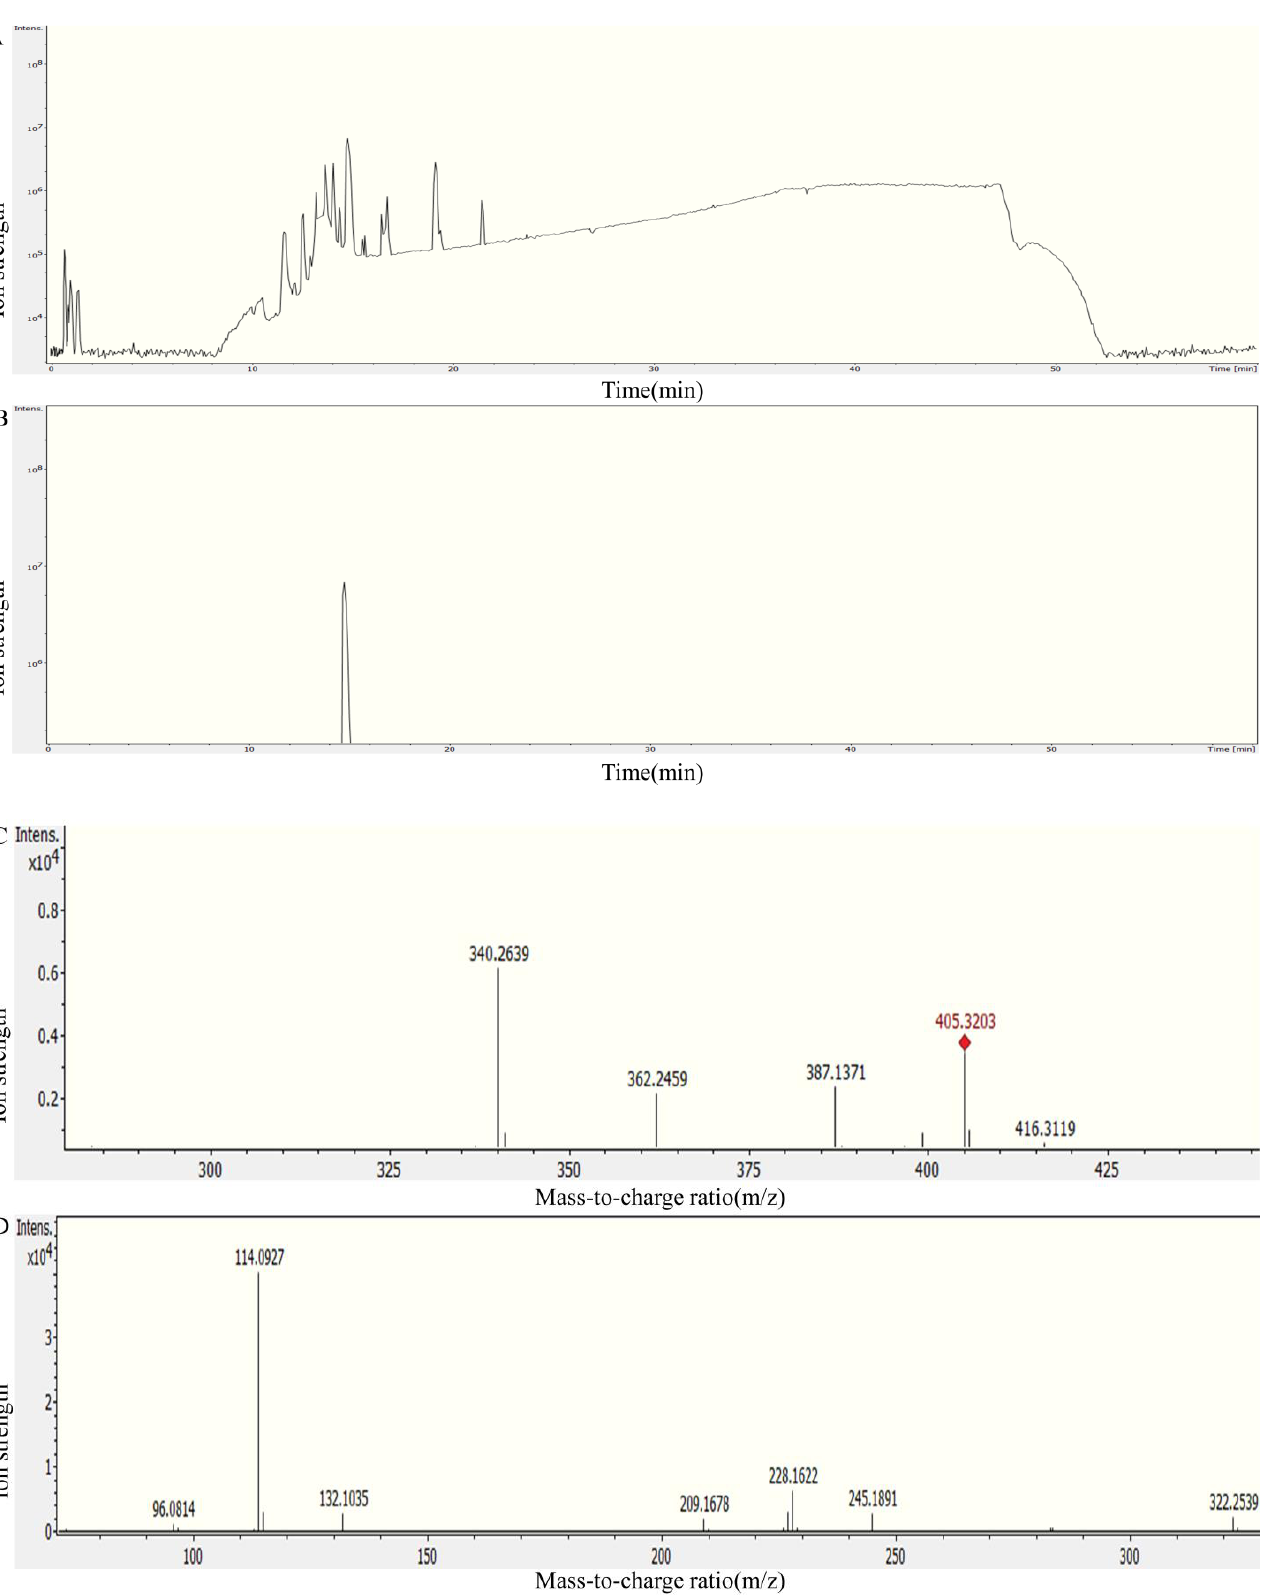
Figure 9. Analysis of FumUPTA degradation of HFB1 by mass spectrometry. ( A ) Total ion flow diagram; ( B ) The EIC chart of 2-keto-HFB1; ( C ) The primary mass spectrum of 2-keto-HFB1; ( D ) The secondary mass spectrum of 2-keto-HFB1.